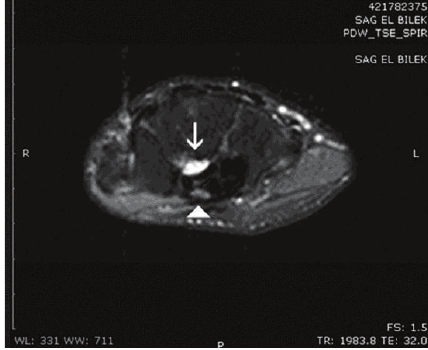
Figure 1: MRI revealed a space-occupying lesion (arrow) in the carpal tunnel and the median nerve (arrowhead) with high signal intensity on fat-suppressed proton density axial images of the wrist.